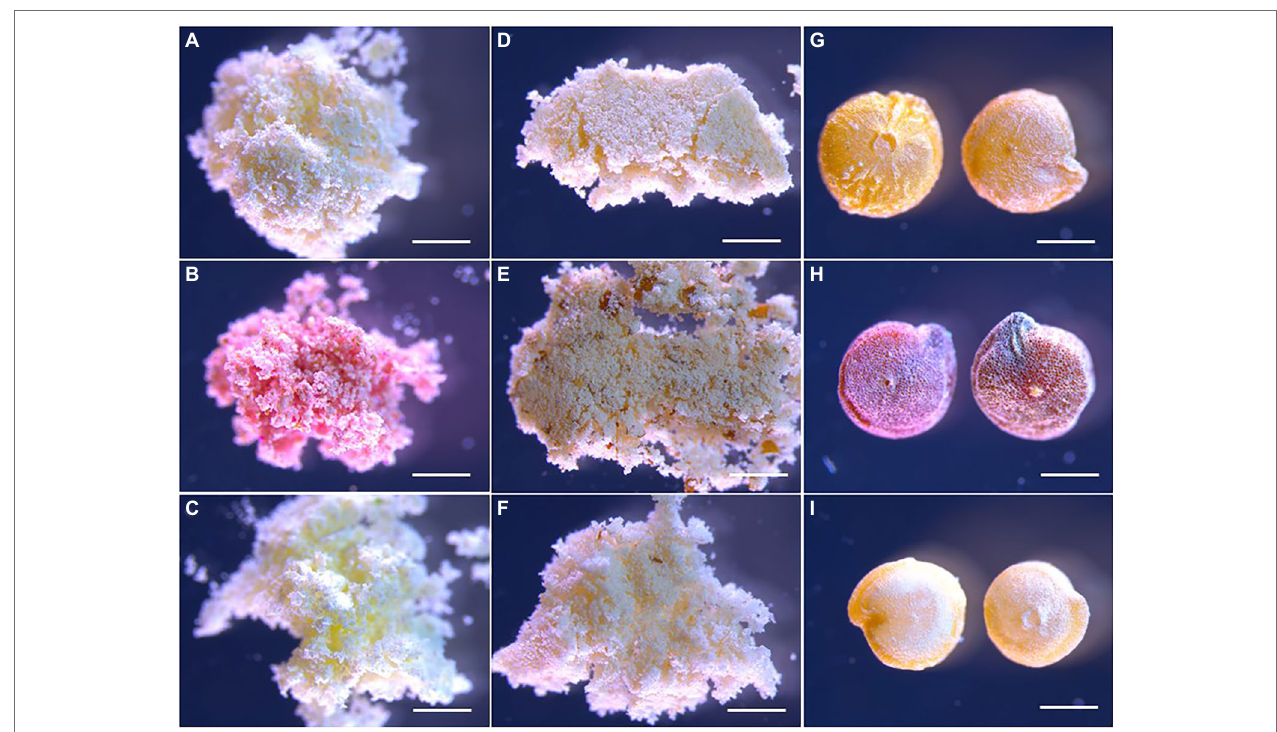
FIGURE 3 | Light microscopy photos of quinoa seed flour from the mid developmental stage (A–C) , flour at maturity (D–F) and whole seeds at maturity (G-I) of Titicaca (A,D,G) , Pasankalla (B,E,H) , and Regalona (C,F,I) . For corresponding dpa for the mid developmental stage, see the text. Scale bars are 1 mm.